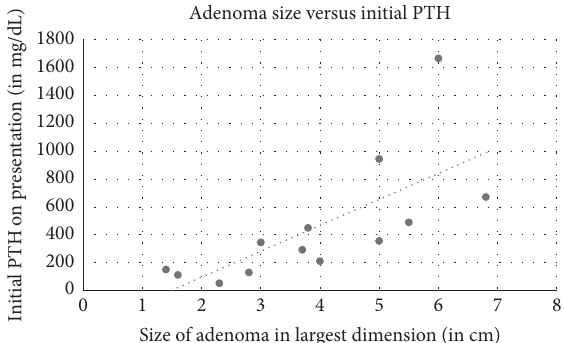
Figure 6: Size of adenoma on pathological evaluation correlation to initial PTH on presentation. Correlation coefficient 0.71.